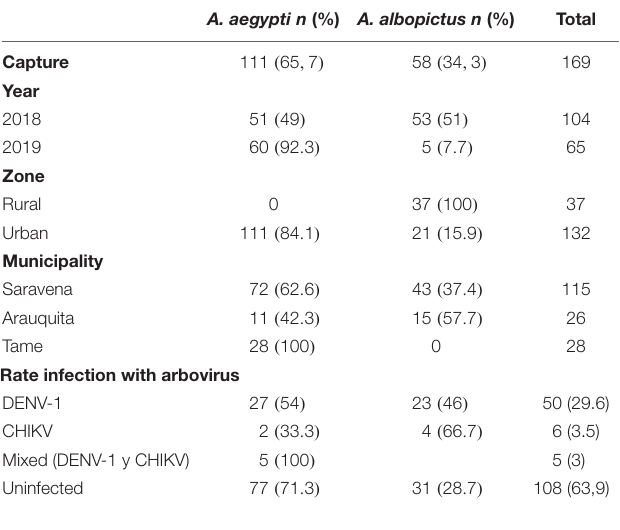
municipality of Arauquita. The above results show clear evidence municipality of Saravena and